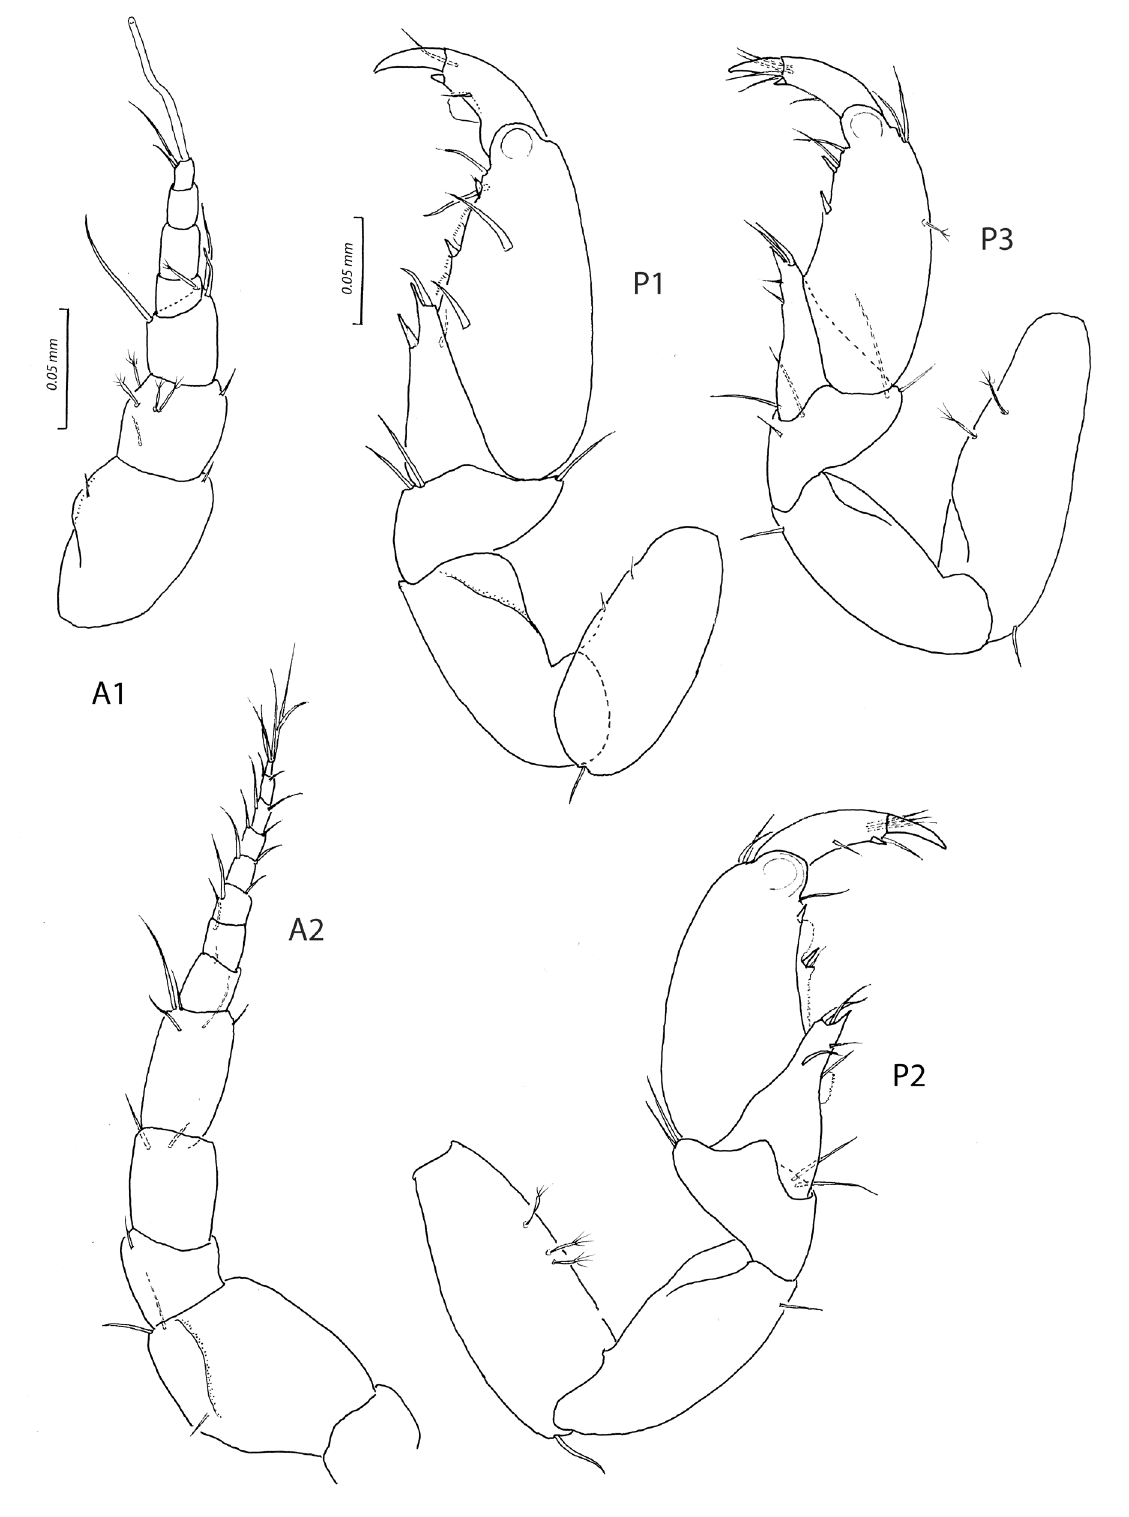
Fig. 7. Kupellonura indonesica sp. nov., holotype, immature adult (MZB Iso 100) . Abbreviations: A1 = antenna 1; A2 = antenna 2; P1–P3 = pereopods